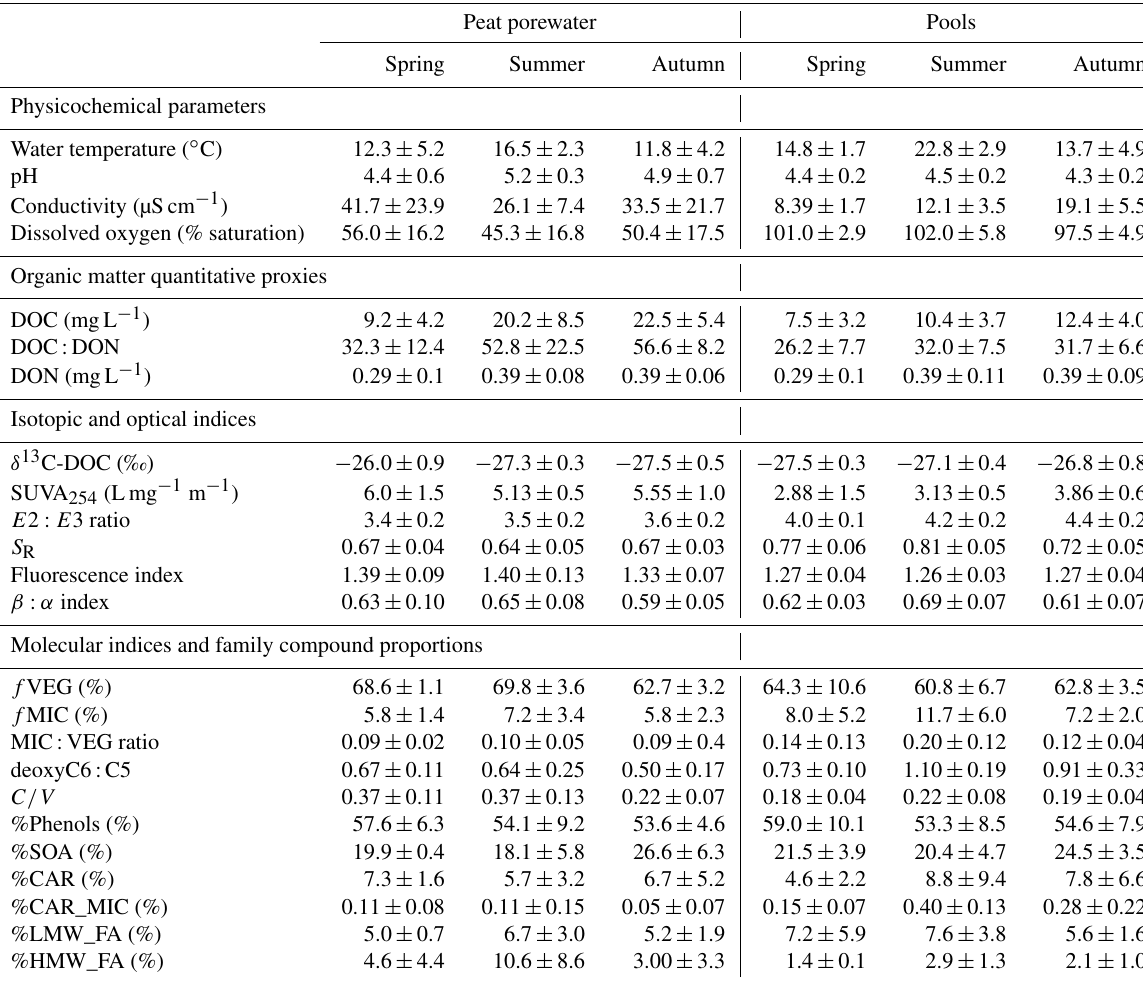
Table 1. Peat porewater and pool seasonal average ( ± SD) of physicochemical variables (water temperature, pH, specific conductivity, and dissolved oxygen saturation), dissolved organic carbon (DOC) concentrations, and the ratio of DOC to dissolved organic nitrogen (DON) (DOC : DON), isotopic signature of DOC ( δ 13 C-DOC), optical indices (SUVA 254 , E 2 : E 3 ratio, and spectral slope ratio), fluorescence indices (FI and β : α index), and molecular indices ( f VEG, f MIC deoxyC6 : C5, and C/V ratio, as well as %Phenols, %CAR, %CAR_MIC, %SOA, %LMW_FA, and